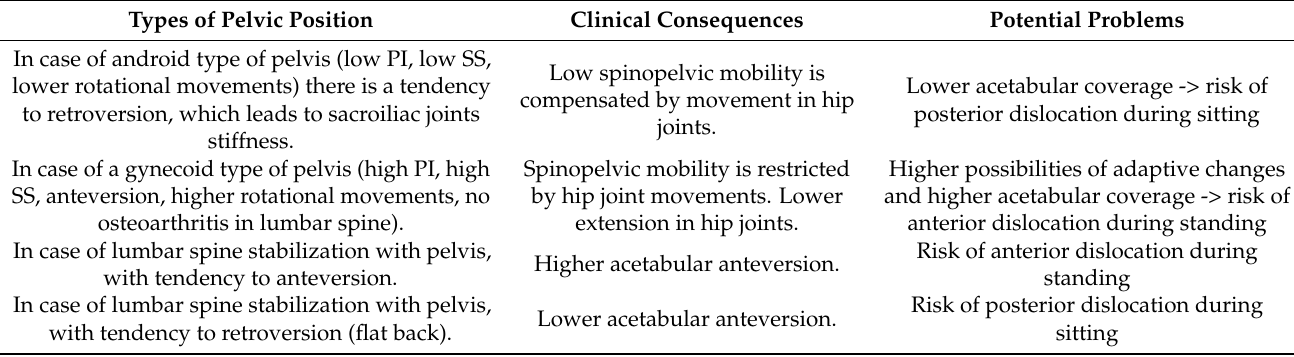
Table 2. Clinical consequences and problems in relation to pelvic